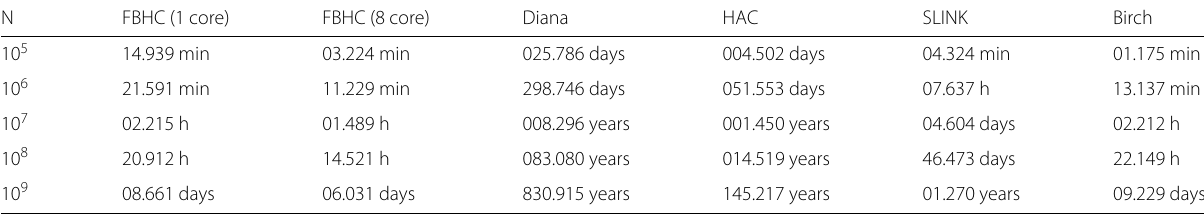
Table 5 Computational complexity of the FBHC method